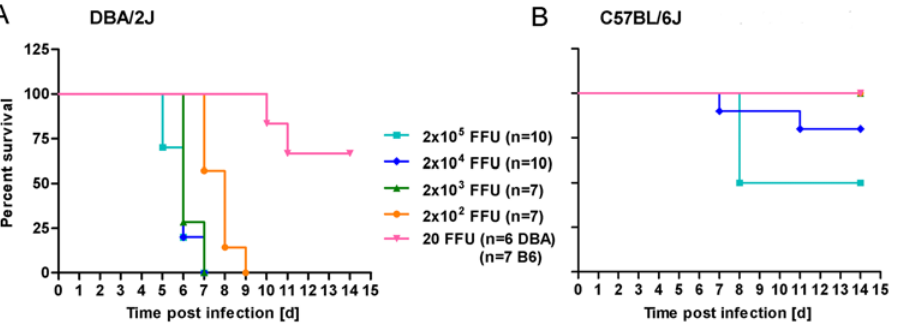
Figure 3. DBA/2J mice are highly susceptible to PR8 infections compared to C57BL/6J mice. DBA/2J (A) and C57BL/6J (B) mice were infected with increasing doses of PR8 virus via the intranasal route and survival was recorded for the following 14 days. Mortality includes also mice that were sacrificed because they had lost more than 25% of body weight.